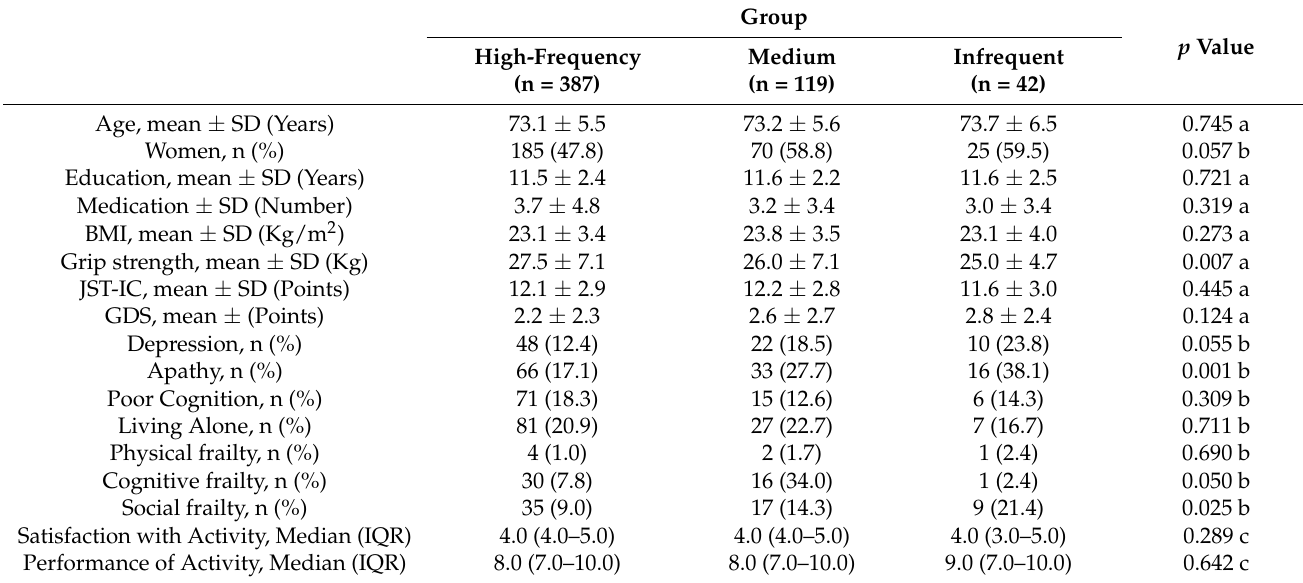
Table 4. Characteristics of differences in the number of driving days per